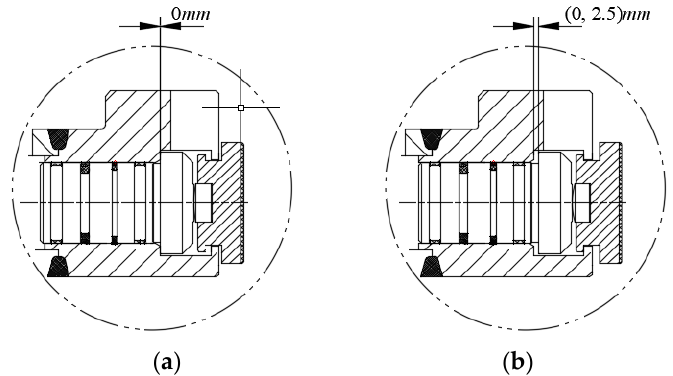
Figure 3. The state of friction damping: ( a ) rigid support state; ( b ) hydraulic support state.